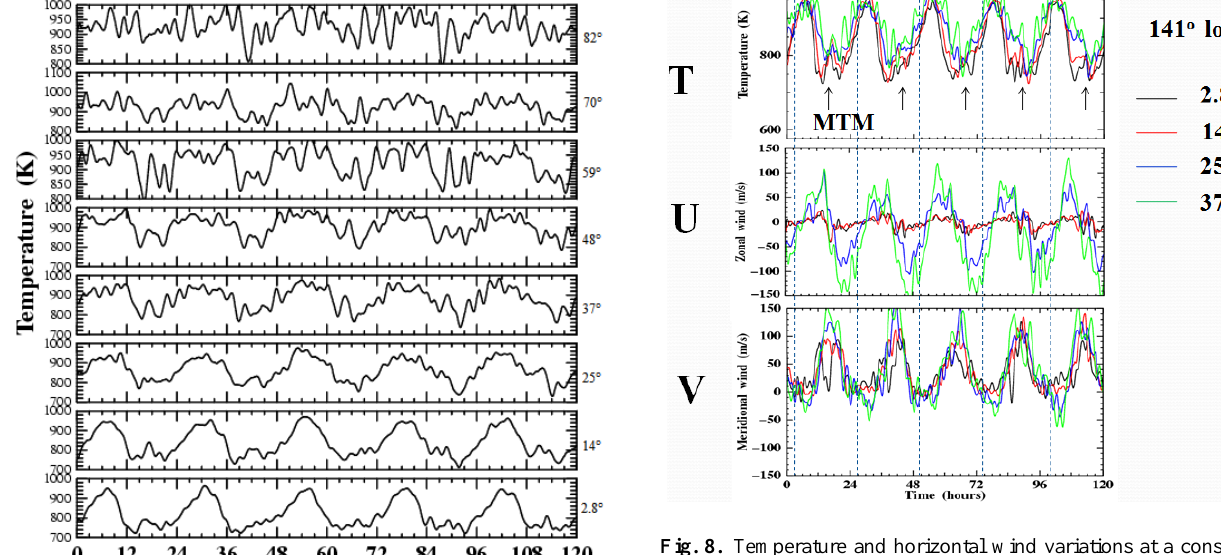
Fig. 8. Temperature and horizontal wind variations at a constant- pressure surface ( ∼ 310km) during 1–5 December in the Southern (summer) Hemisphere at 141 ◦ E longitude and 37 ◦ S (green line), 25 ◦ S (blue line), 14 ◦ S (red line), and 2.8 ◦ S (black line) latitudes. The values on the abscissa axis indicate hours from 00:00UT on 1 December. The vertical dashed lines denote the times correspond- ing to local noon